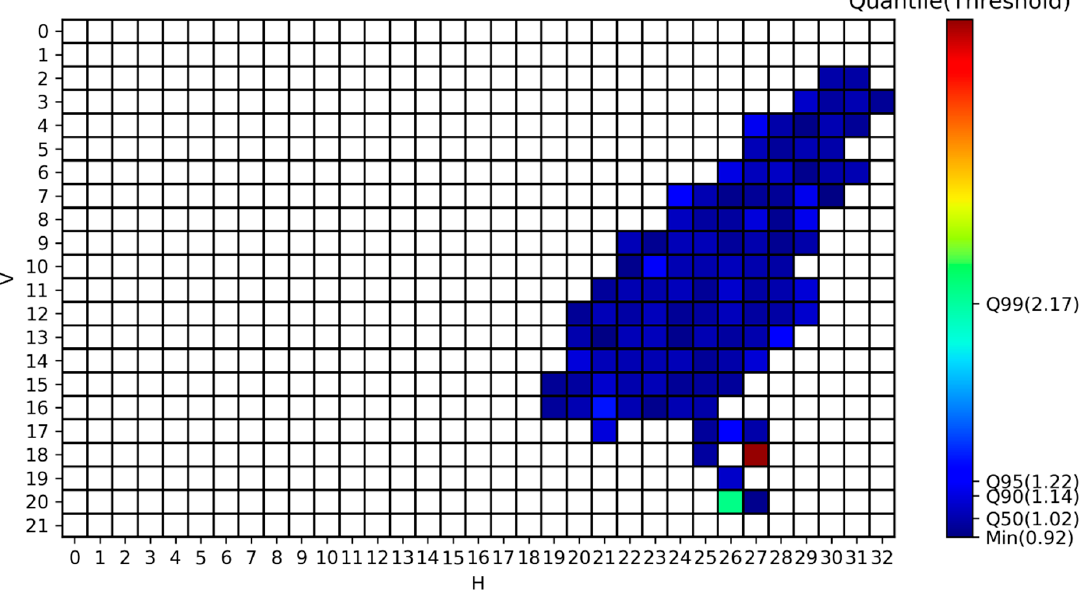
Figure 3. Illustration of outlier detection results during the first production. The color bar shows LOS value at the 50%, 90%, 95%, and 99% cut points. X and y axes show horizontal (H) and vertical (V) tile number, respectively.